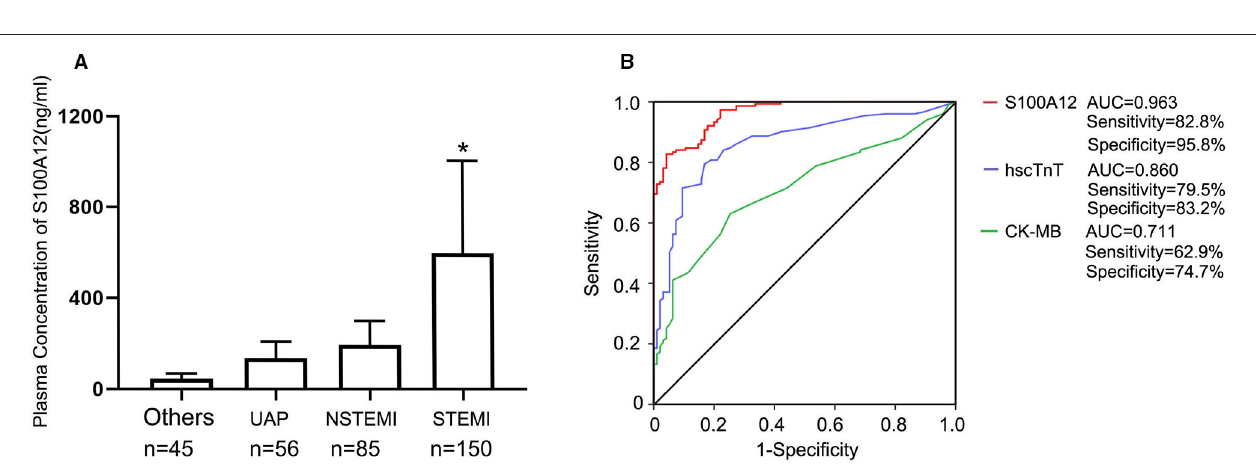
FIGURE 3 | Diagnostic accuracy of S100A12 in patients presenting within 2h of symptom onset; (A) Plasma concentration of S100A12 in patients with a final adjudicated diagnosis of STEMI, NSTMI, UAP and others; (B) The AUC for S100A12, hscTnT, and CK-MB in the STEMI cohort presenting ≤ 2h after symptom onset ( n = 150). UAP, unstable angina pectoris; PTE, pulmonary thromboembolism; AD, aortic dissection; NSTEMI, non-ST-segment elevation myocardial infarction; STEMI, ST-segment elevation myocardial infarction.